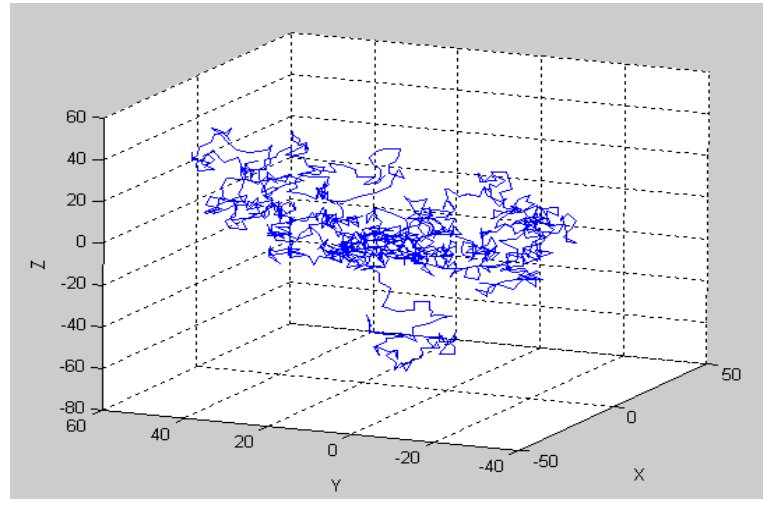
Figure 19. Random route with 1,000 points in 3-dimensional space.